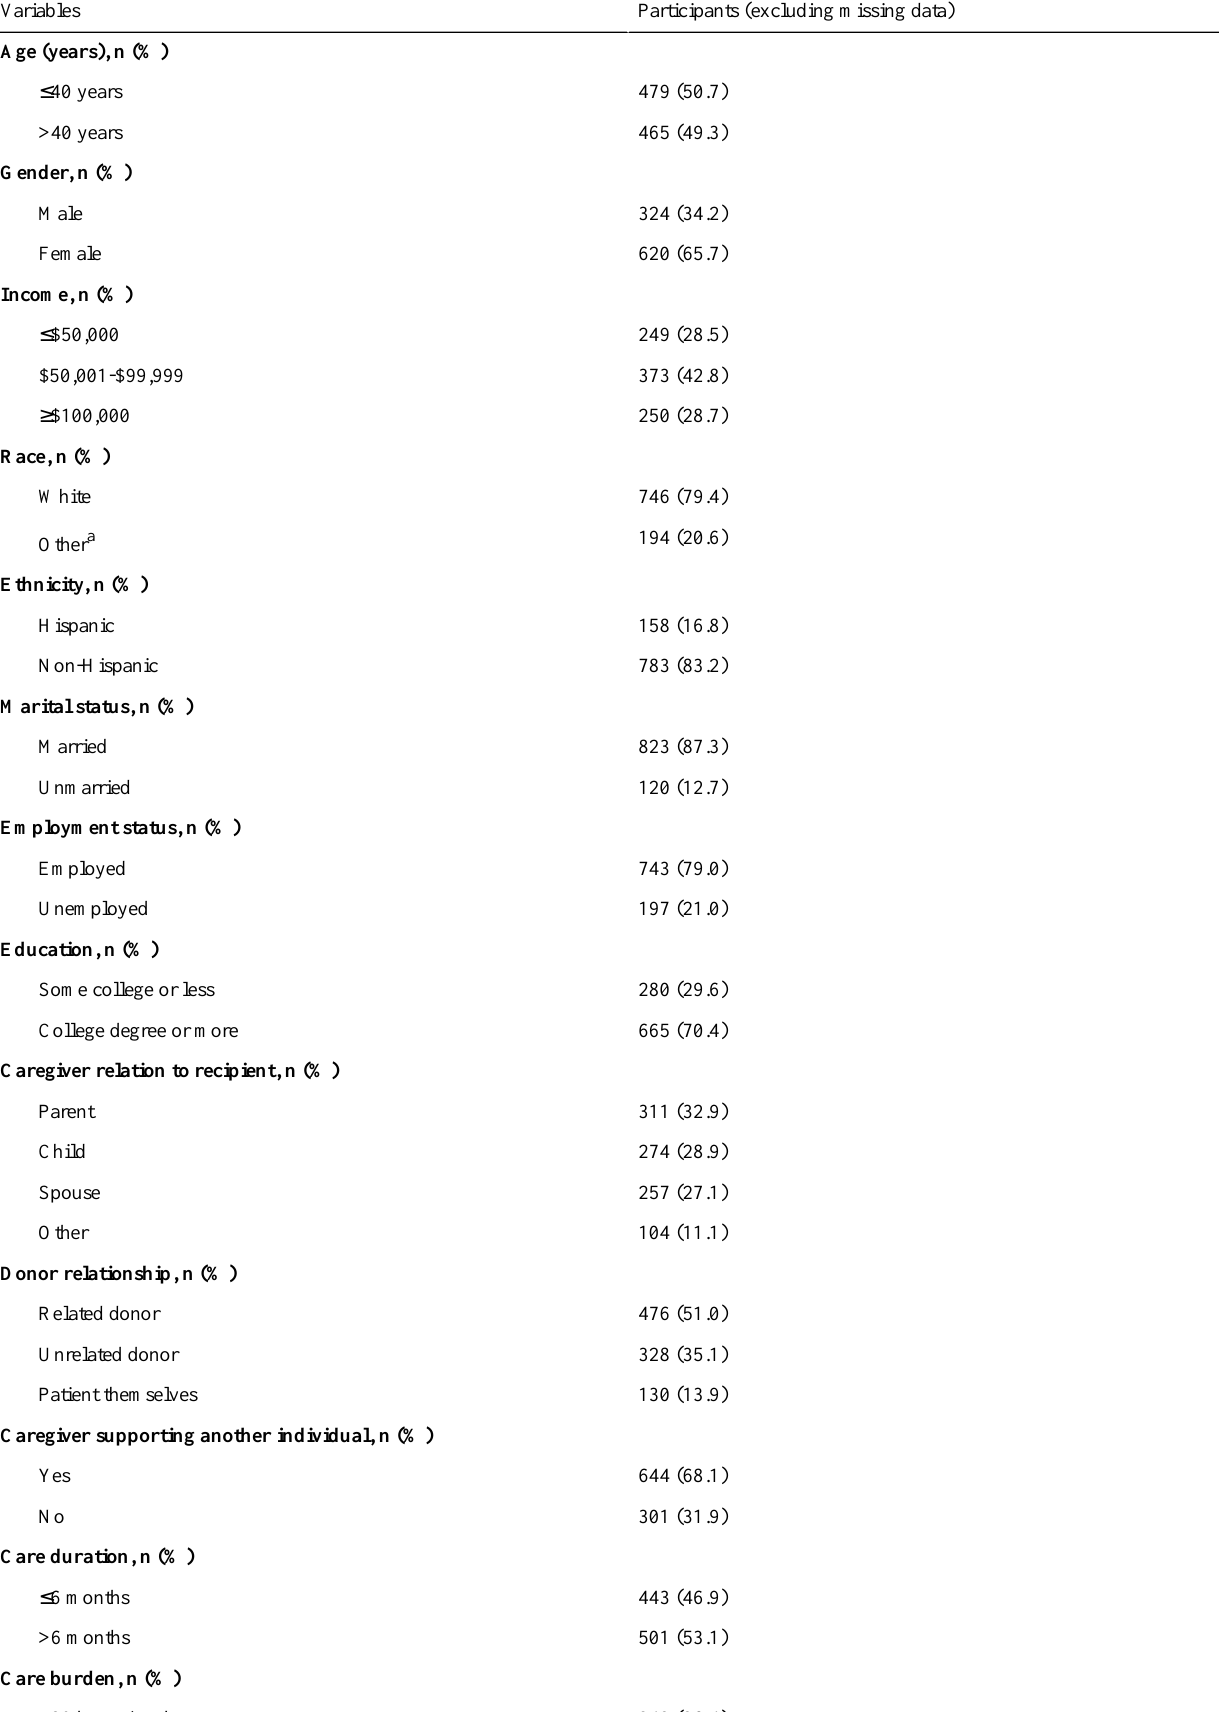
Table 1. Summary of caregiver demographics and caregiving